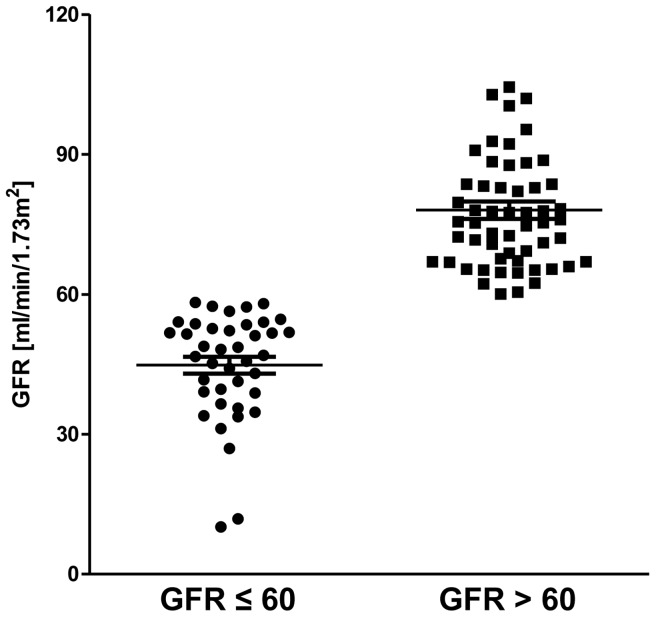
Glomerular filtration rate (GFR).Distribution of GFR (ml/min/1.73 m2) among patients’ groups. Mean GFR was 45±11 ml/min/1.73 m2 (range: 10 to 58 ml/min/1.73 m2) and 78±14 ml/min/1.73 m2 (ranging from 61 to 136 ml/min/1.73 m2).